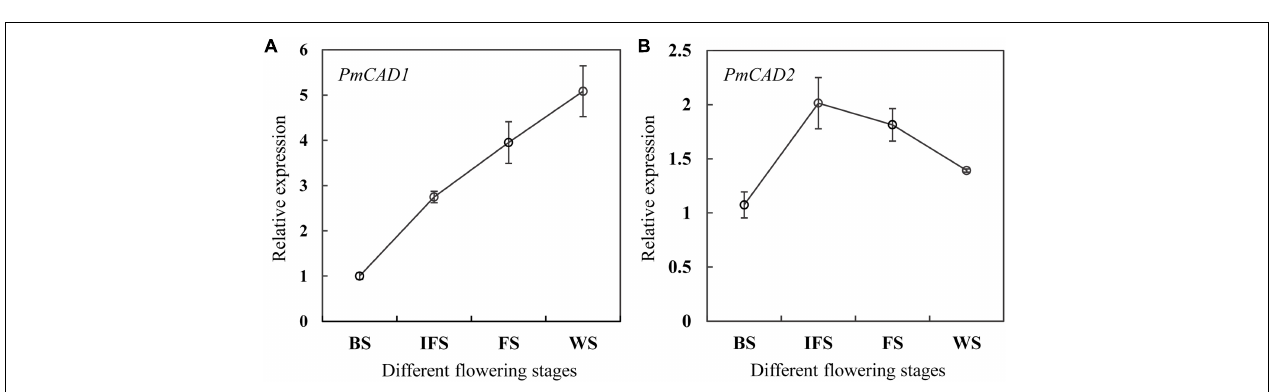
FIGURE 6 | The relative expression levels of PmCAD1-2 at different flowering stages of P. mume ‘Fenh.’ (A,B) Relative expression of PmCAD1 and PmCAD2 at different flowering stages of P. mume ,